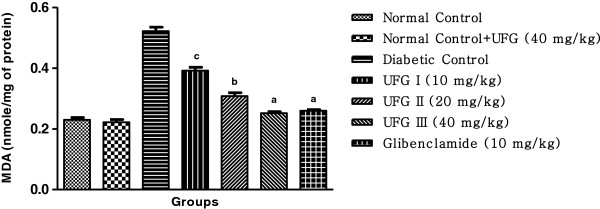
Effect of umbelliferone β-D-galactopyranoside on level of MDA (Malondialdehyde) cholesterol at different concentrations on STZ induced diabetic rats, compared to diabetic control group rats; values are mean ± SEM; n = 6;
c
P < 0.05;
b
P < 0.01;
a
P < 0.001; P > 0.05 is considered as non-significant (ns).